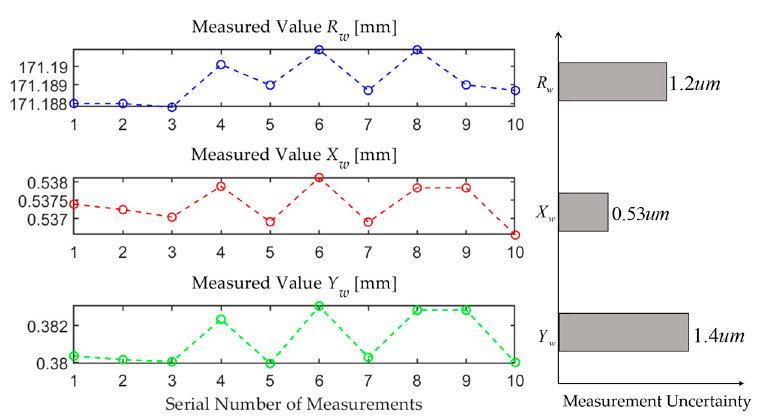
Figure 13. Measurement results of actual collected data and measurement